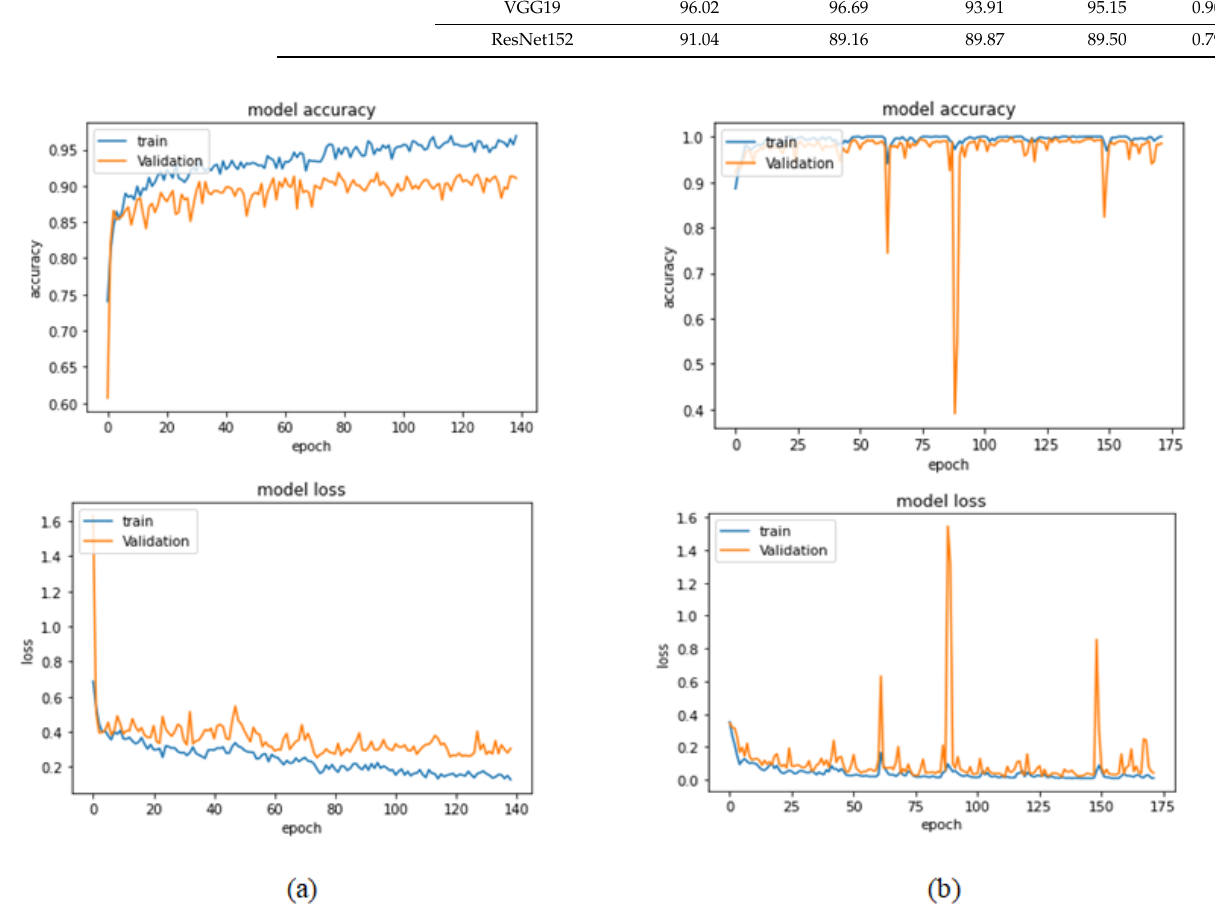
Figure 17. Learning curves for Xception at 0.0001 learning rate in 200× magnification-dependent binary classification. ( a ) Accuracy and loss curves of Phase 1 of training. ( b ) Accuracy and loss curves of Phase 2 of training.